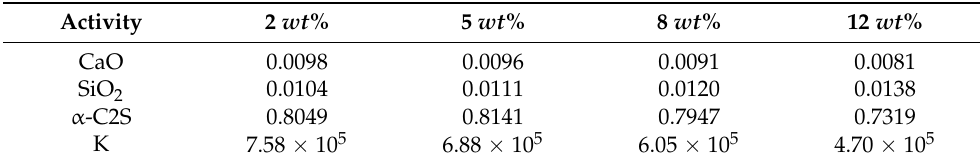
Table 2. Activity calculation of FactSage 7.3 at 1550 °C.